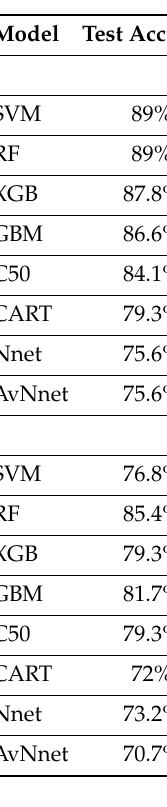
Figure 4. Accuracy and kappa values displaying model fit for eight classification models built using either 1 s or 2 s epoch. Higher values are a better fit. Table 5. Average (out-of-sample) test results of classification models for 1 and 2 s